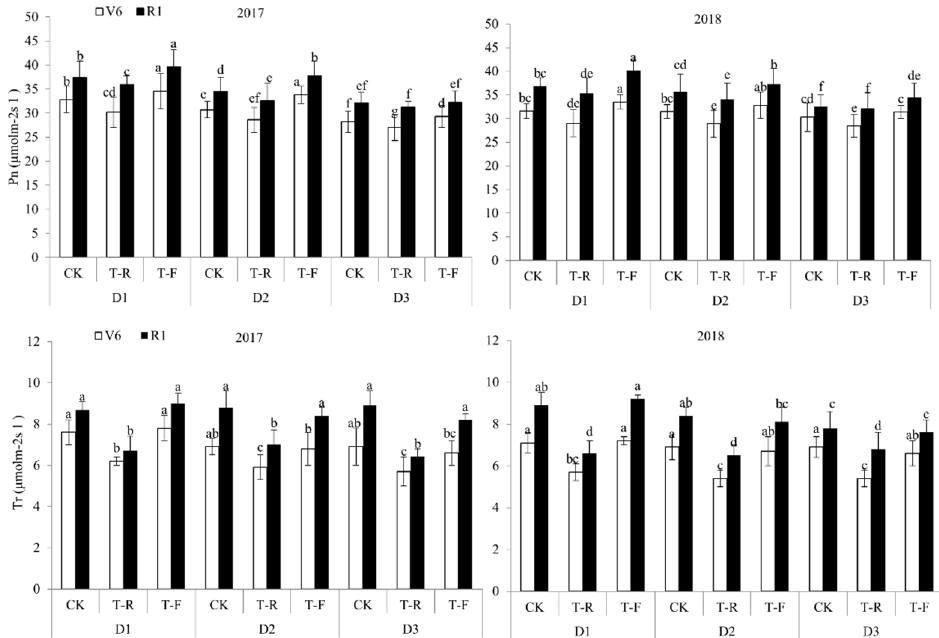
Figure 7. The photosynthetic rate and transpiration rate of maize under different planting patterns. At the same testing time different letters above the bars indicate that there is a significant difference between treatments at p < 0.05. D1, D2 and D3 represent maize were planted at 60,000, 75,000 and 90,000 plants ha − 1 , respectively. CK and T represent maize were planted in the conventional flat planting pattern and in the stereo-planting pattern, respectively. T-R and T-F represent maize were planted on the ridge and in the furrow, respectively. V6 and R1 represent the 6-leaf stage and the silking stage, respectively. The vertical bar means the standard errors ( n = 3).